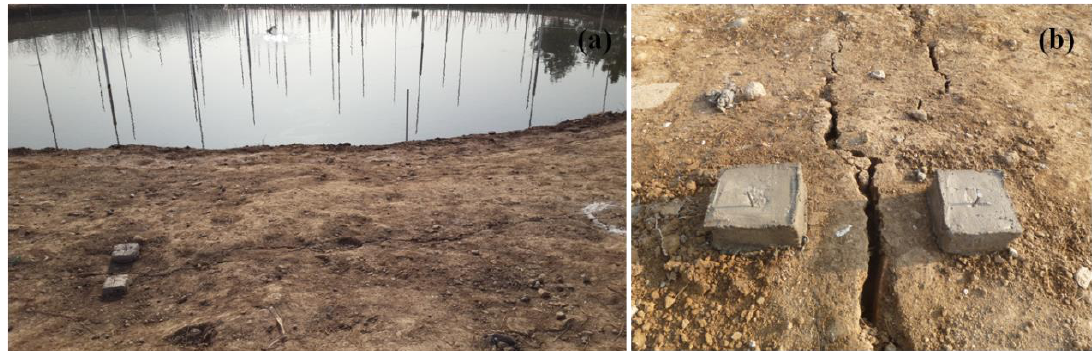
Figure 12. Location of ground fissures, ( a ) cracks caused by collapse of loess, ( b ) the cracks.